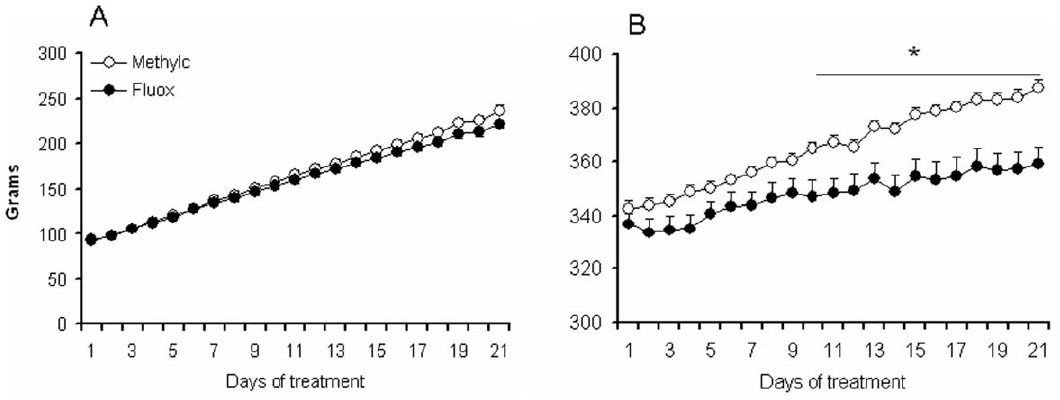
Figure 1. Effect of fluoxetine on body weight in adolescent and adult rats. Data are presented as mean 6 S.E.M. body weight (g) in adolescent rats (A) and adult (B) rats (n=10). 21 Days of fluoxetine treatment had no effect on bodyweight of adolescent rats, but reduced bodyweight in adult rats. * p , 0.05 fluoxetine versus methylcellulose in age group.